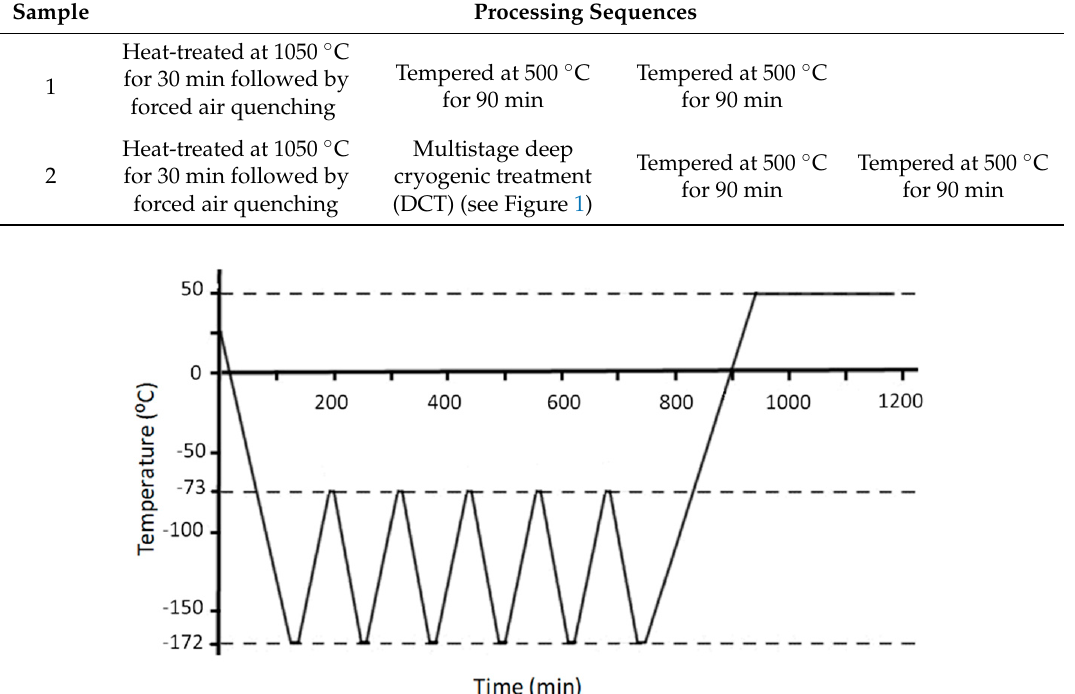
Figure 1. Cryogenic multistage treatment performed on Sample 2.